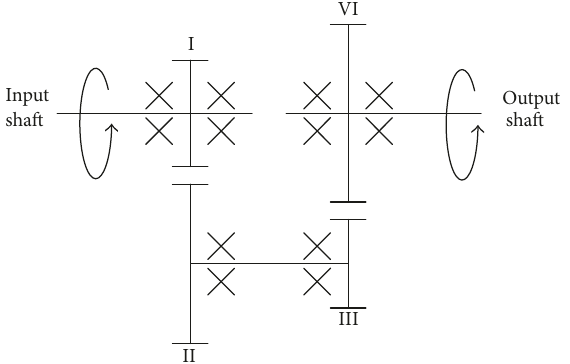
Figure 4: Schematic of a two-stage